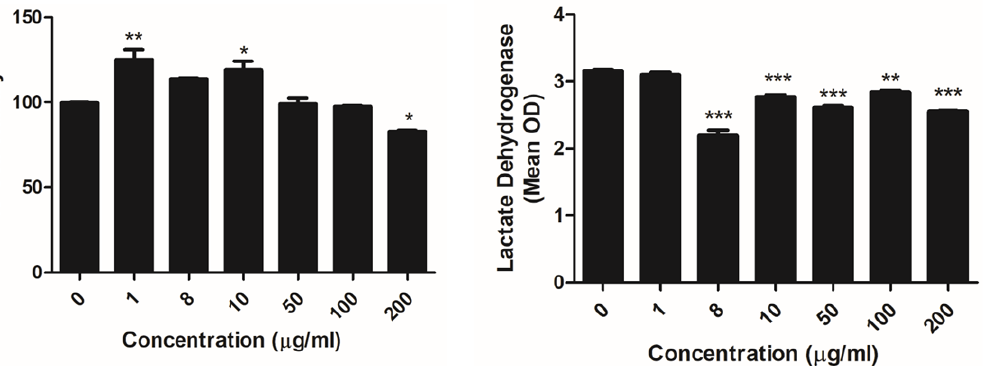
Figure 2. Cell viability studies conducted on HepG2 cells using varying concentrations of BP2 . Cell